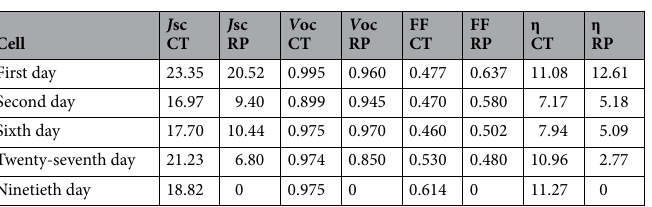
Table 3. PV performance of CIS-PSCs with CT and RP TiO 2 ETLs measured during 90 days at ambient temperature and humidity.